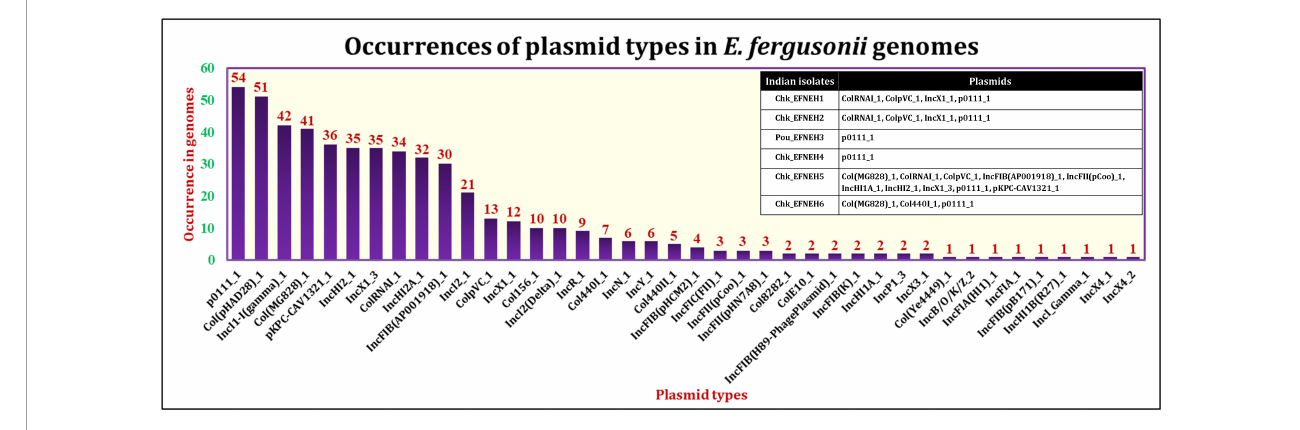
FIGURE4 Occurrences of various plasmid types in E. fergusonii genomes.